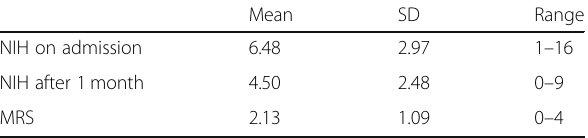
Table 5 Mean value of NIH on admission after 1 month and